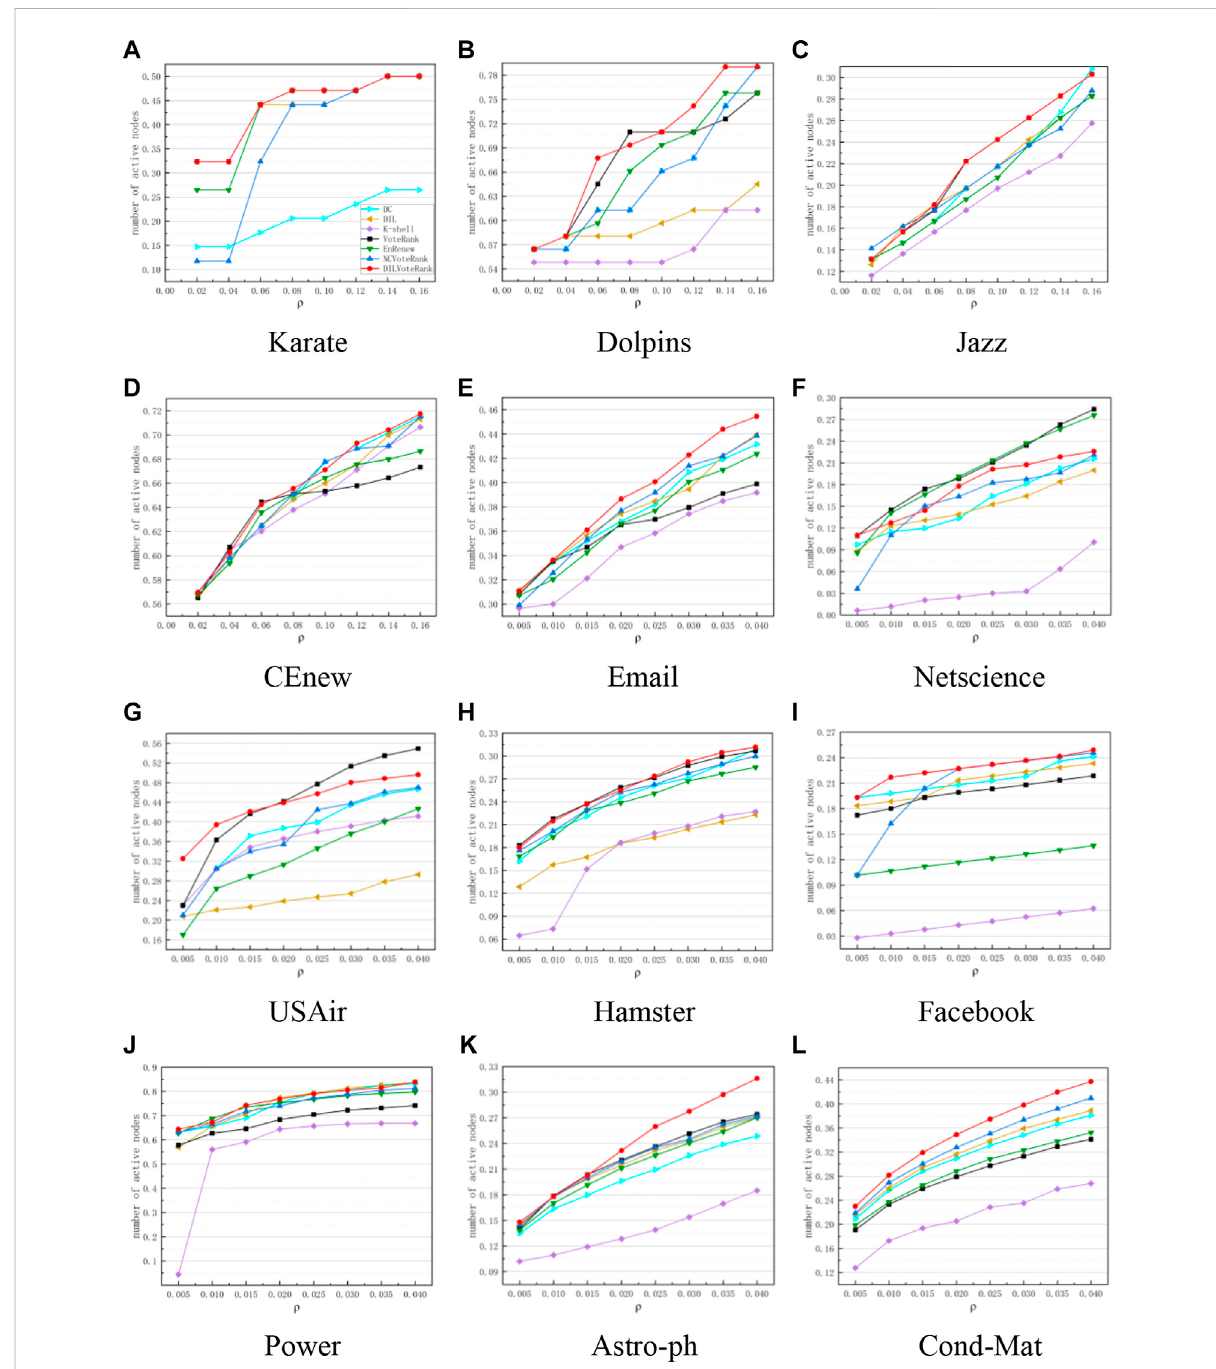
FIGURE 5 The change curve of the number of activated nodes in the stable stage with different initial node proportions, the experimental results are the average of 1,000 simulations. Subgraphs (A – L) respectively represent the experimental results of 12 datasets in Table